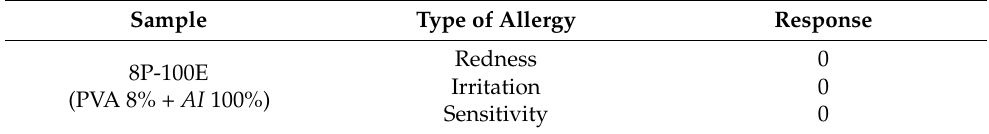
Table 2. Results of skin patch